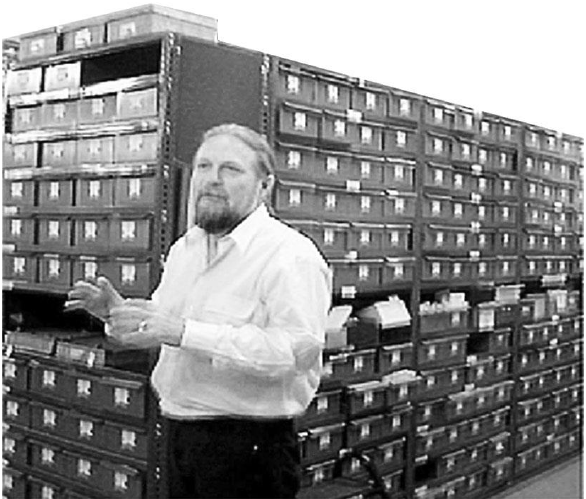
Figure 4. Inside the archive of the UCR/CMP Keystone-Mast-